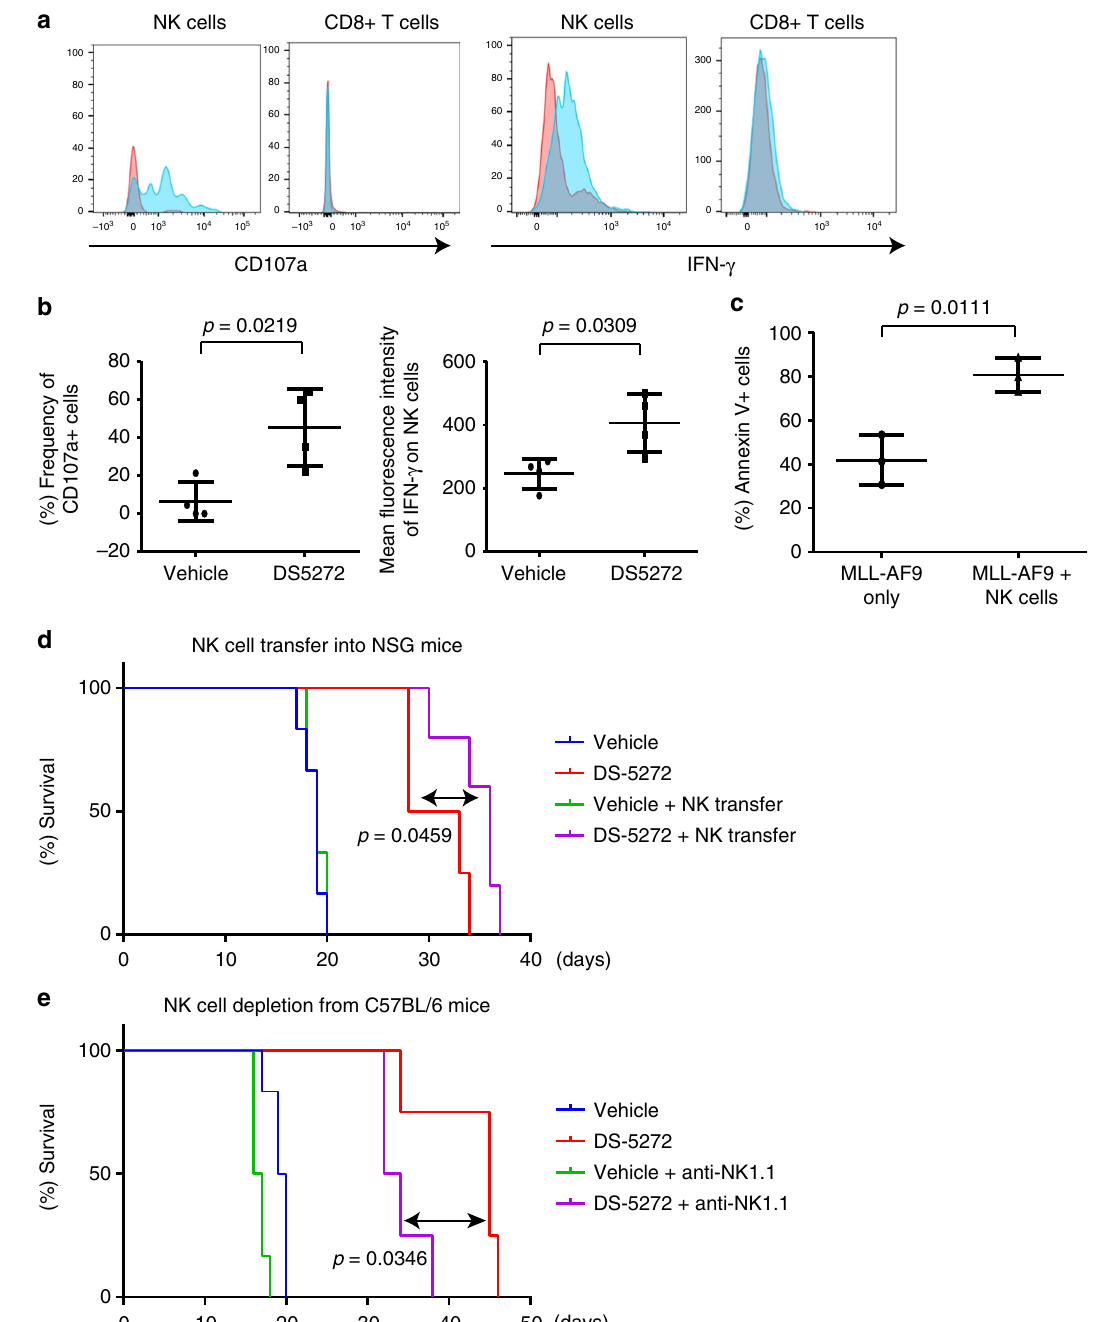
Fig. 7 NK cells contribute to the antileukemia effect of DS-5272. a Representative FACS plots showing cell surface expression of Cd107a (left) and intracellular expression of IFN- γ (right) in NK cells and Cd8 + T cells in bone marrow. b Quanti fi cation of frequency of Cd107a + cells (left) and mean fl uorescence intensity (MFI) of IFN- γ (right) in NK cells. Data are shown as mean ± s.d. of four biologically independent samples. Student t -test. c MLL- AF9 leukemia cells were co-cultured with or without NK cells. Frequency of Annexin-V + cells in MLL-AF9 leukemia cells was assessed after 48 h of co- culture. Data are shown as mean ± s.d. of three biologically independent samples. Student t-test. d Kaplan – Meier survival curves of NSG mice injected with MLL-AF9 cells or MLL-AF9 cells + NK cells, that were treated with vehicle control or DS-5272. (Vehicle: n = 6, DS-5272: n = 4, Vehicle + NK: n = 6, DS-5272 + NK: n = 5). Statistical signi fi cance was evaluated by the log rank test. e Kaplan – Meier survival curves of C57BL/6J mice injected with MLL-AF9 cells, that were treated with vehicle control, anti-NK1.1, DS-5272 or DS-5272 + anti-NK1.1. (Vehicle: n = 6, DS-5272: n = 6, Vehicle + anti- NK1.1: n = 4, DS-5272 + anti-NK1.1: n = 4) Statistical signi fi cance was evaluated by the log rank buffer (provided by H.T.) These cells were counted and resuspended in PBS (1× conjugation kit (Fluidigm PRD002 Version7) according to the manufacturer ’ s 10 7 per ml), stained with live/dead cell indicator Cell-ID TM Cisplatin (Fluidigm, recommended protocol. For sample preparation, MLL-AF9 cells were isolated from femurs and tibias of Cat# 201198) at a fi nal concentration of 5 μ M, and were then fi xed with 1 ×Maxpar mice treated with vehicle or DS-5272 24h before. After fi ltration with Falcon Cell FixIBuffer (Fluidigm, Cat# 201065). 1 ×10 6 cells/sample were aliquoted and were Strainer (mesh size 40 μ m, Cat# 087711), red cells were removed using 1x ACK stained with 26 antibodies (Supplementary Table 3) according to the Maxpar